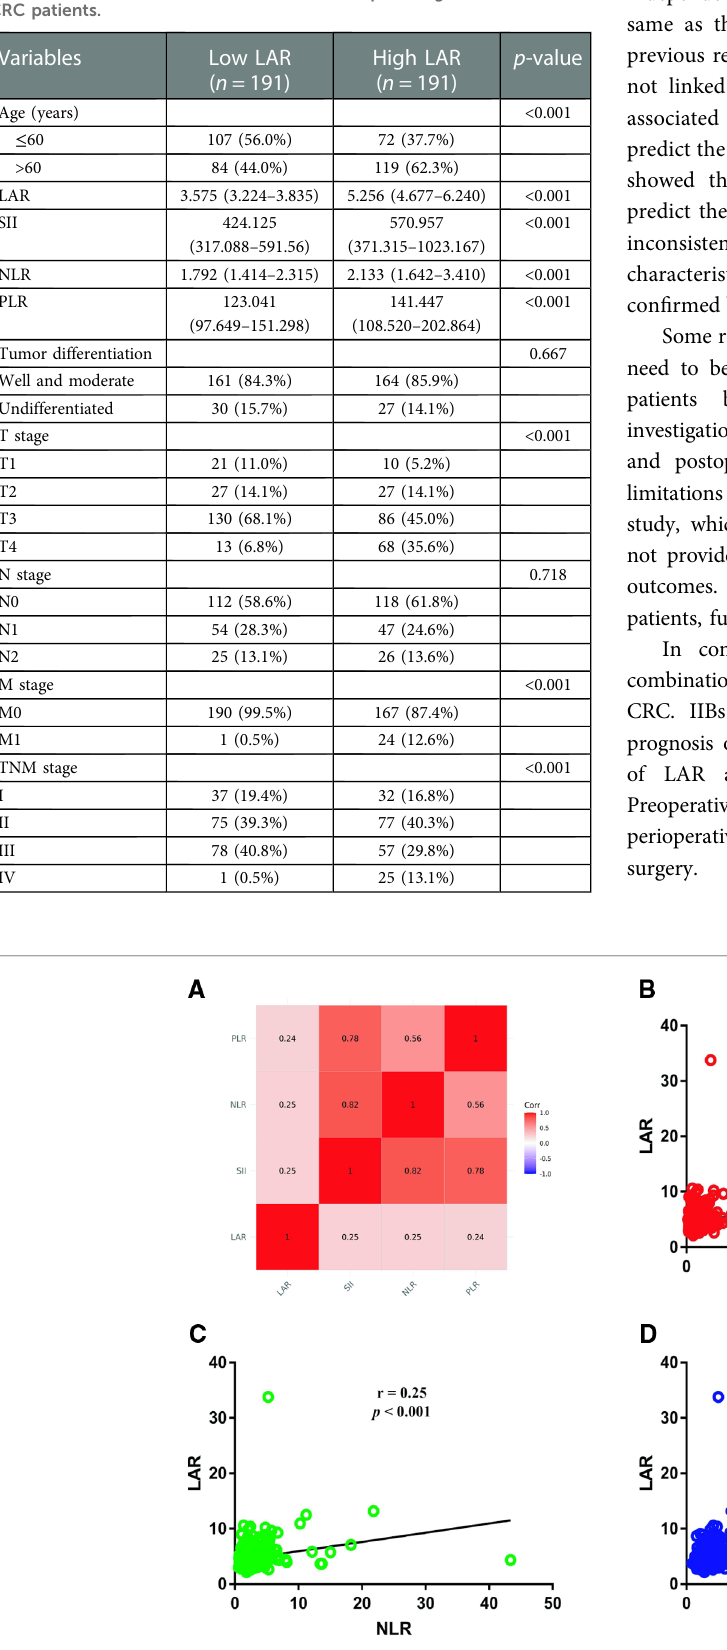
FIGURE 8 Correlation between LAR and SII, NLR and PLR ( A ). ( B ) Correlation between LAR and SII; ( C ) Correlation between LAR and NLR; ( D ) Correlation between LAR and